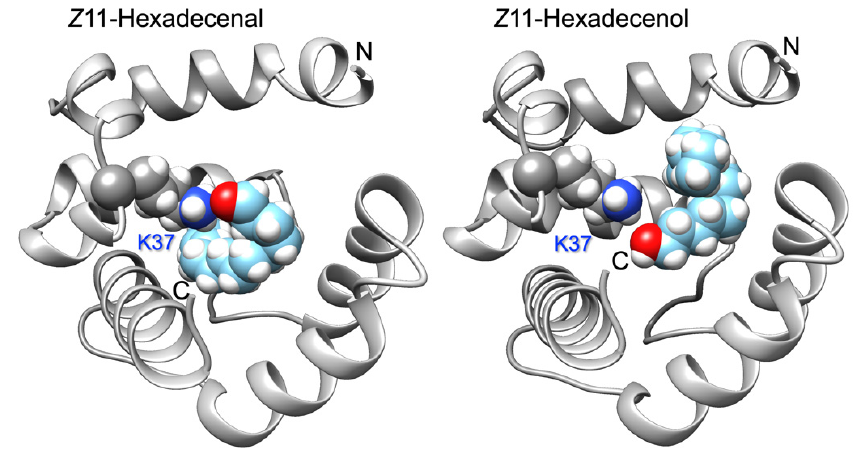
Figure 3. Docking of the best ligands, Z11-hexadecenal and Z11-hexadecenol, to a model of ApisOBP9. Both ligands fit inside the binding cavity with their functional groups at short distance from the ε -amino group of Lys37. N- and C-termini are indicated. The model was obtained using the on-line program Swiss-Model. Docking simulations were performed with the program Swiss-Dock. Structures were visualized using the software Chimera.